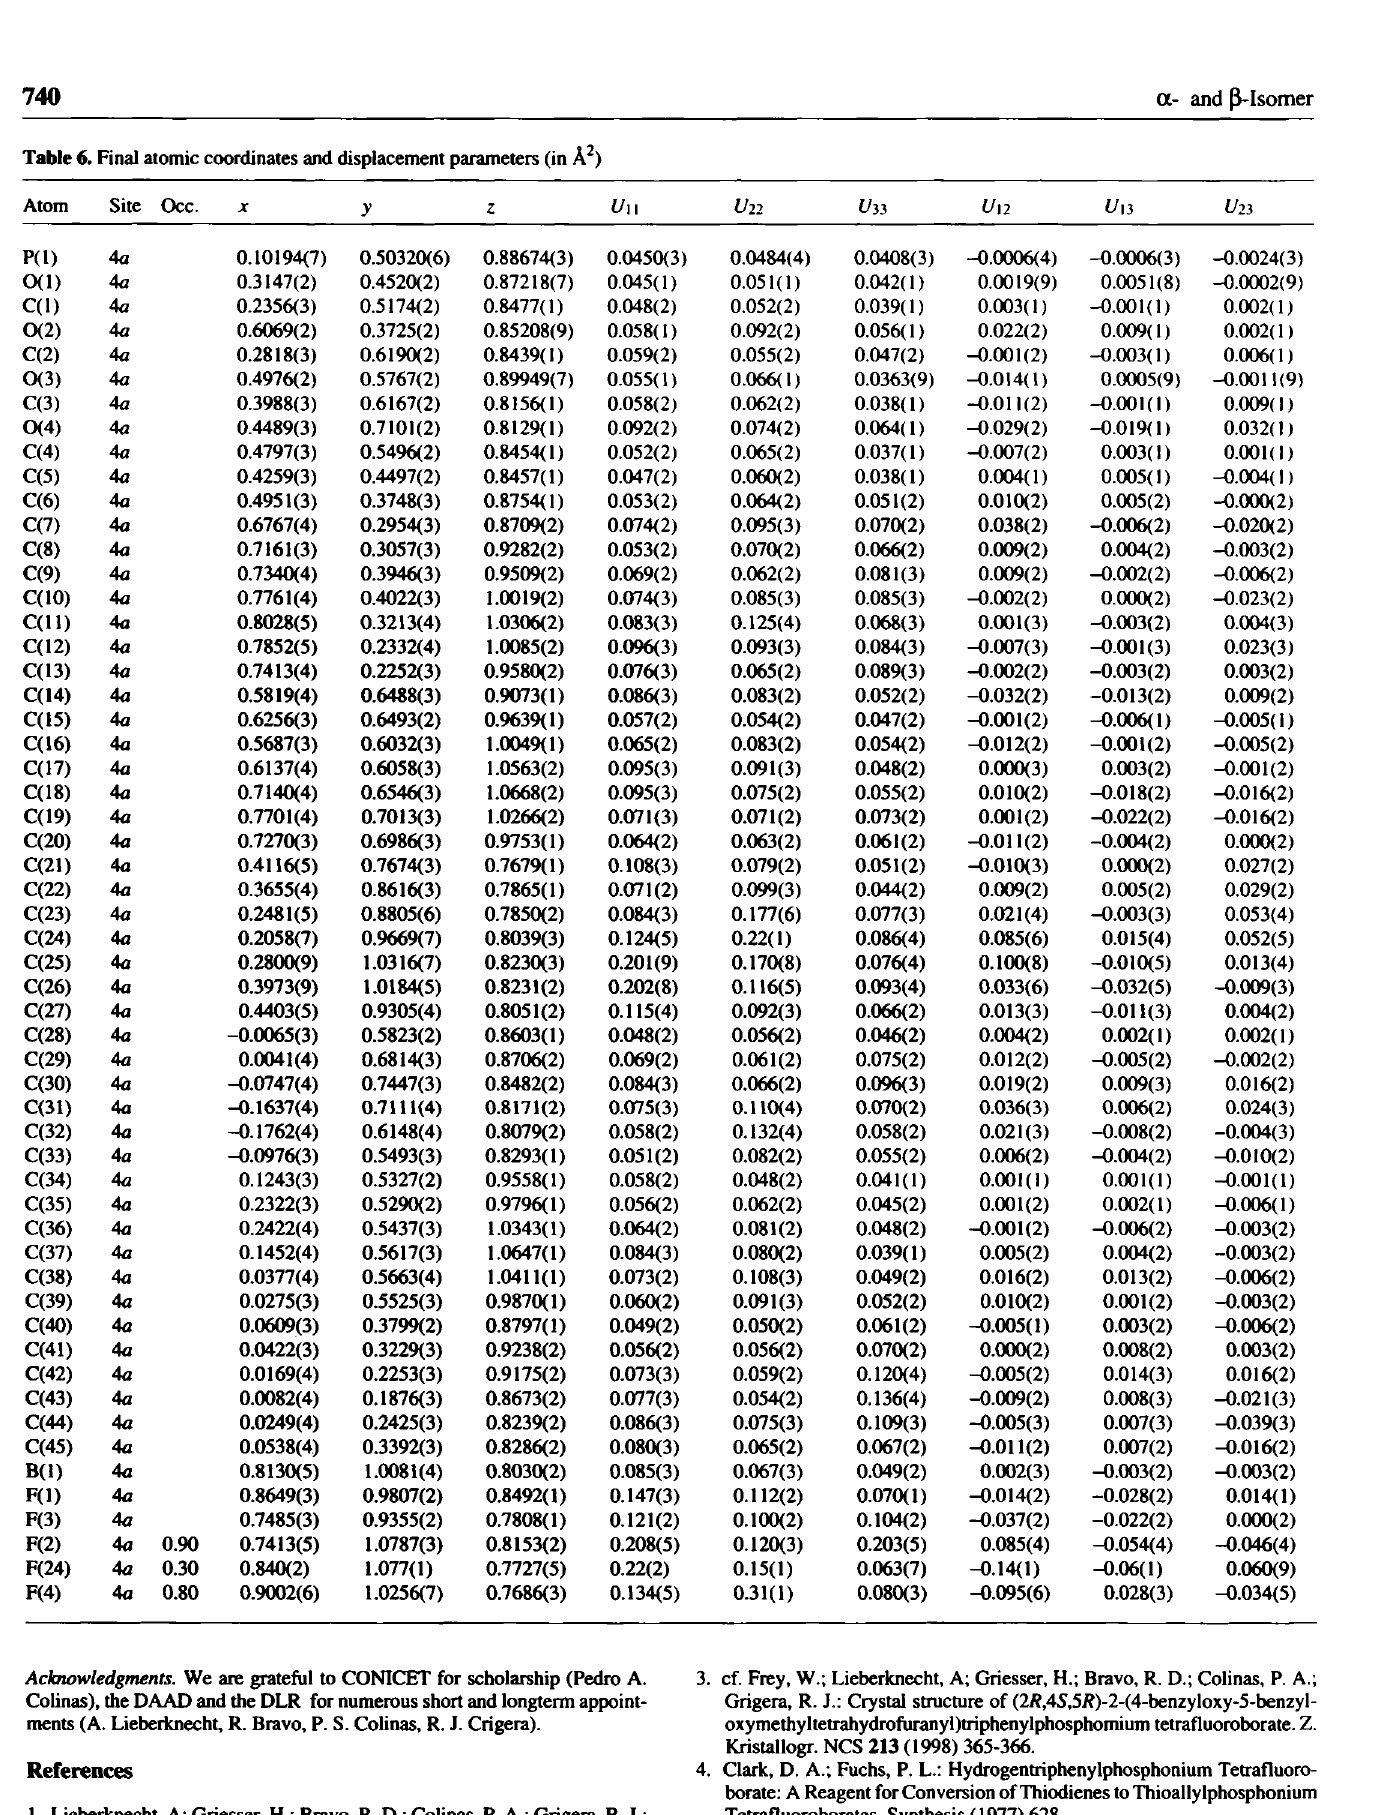
Table 6. Final atomic coordinates and displacement parameters (in Â^) Atom Site